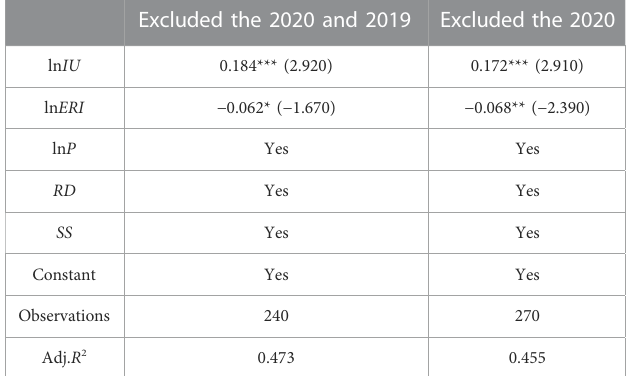
TABLE 8 Robustness test 3: Change the sample